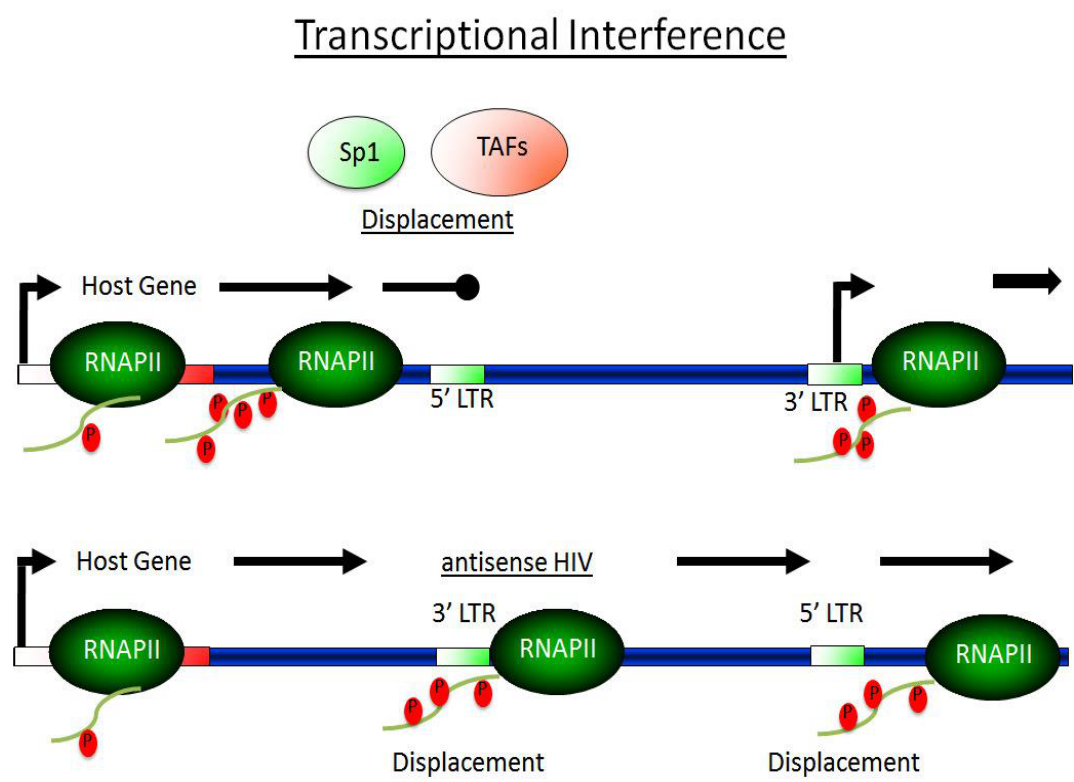
Figure 2. TI promotes HIV latency . HIV provirus integrates into actively